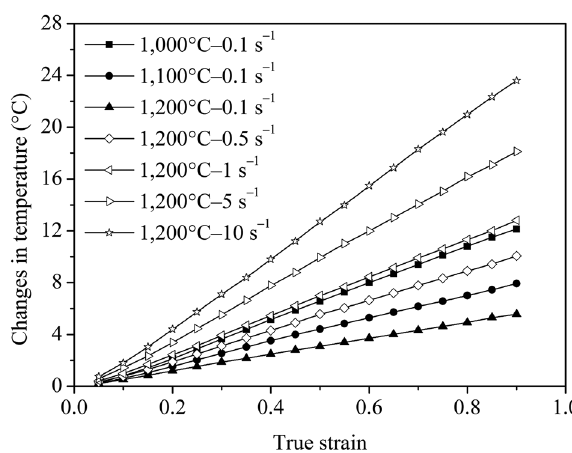
Figure 3: Changes in temperature under different deformation